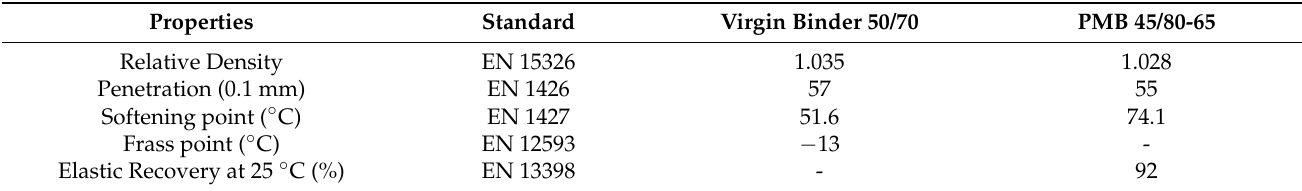
Table 1. Properties of bitumen used in the study.